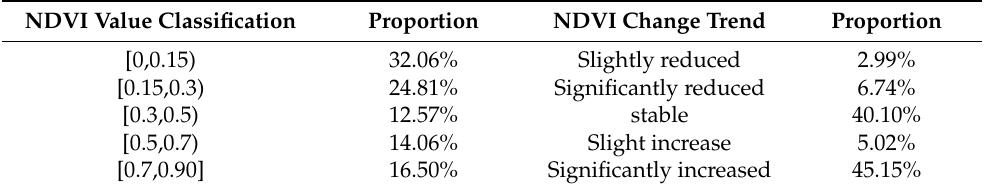
Figure 8. Time change trend of the normalized difference vegetation index (NDVI) from 1998 to 2018. Table 5. The proportion of the NDVI and its change trend from 1998 to